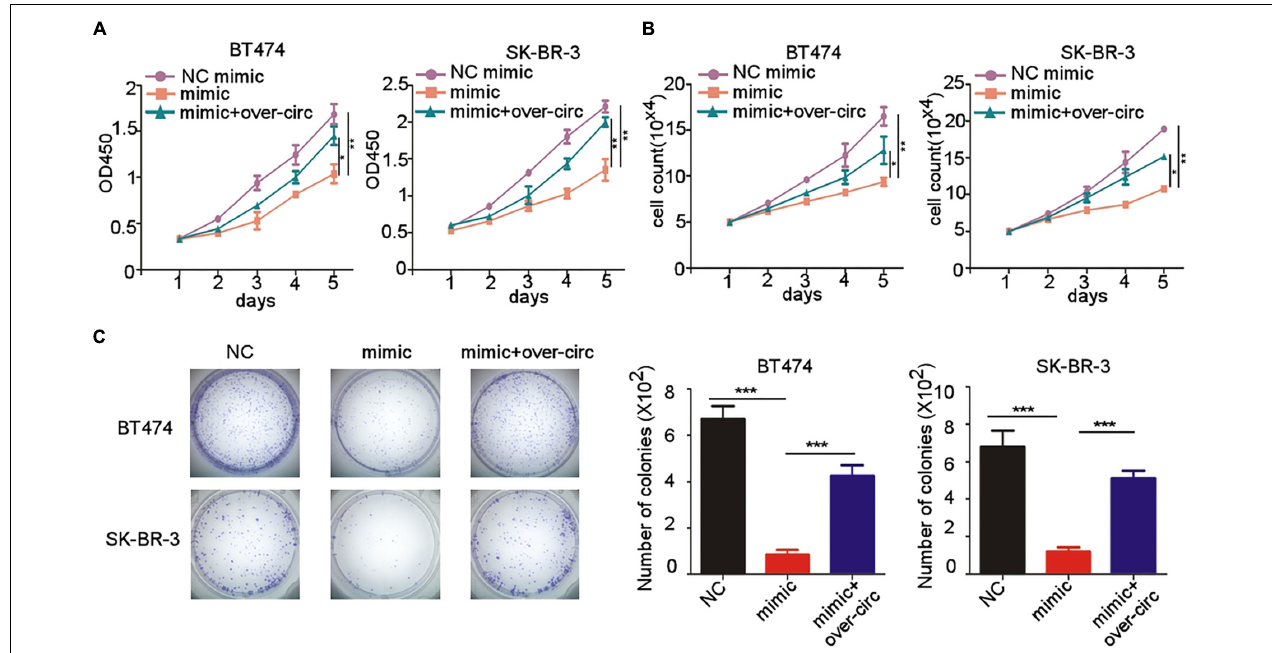
FIGURE 5 | miR-92b-3p inhibits proliferation of HER2 + BC cells by down-regulation of circCDYL. (A,B) The proliferation of SK-BR-3 and BT474 cells after transfection of miR-92b-3p mimic or co-transfection of miR-92b-3p mimic and circCDYL over-expressing plasmid, as detected by CCK-8 assay (A) and cell counting experiments (B) . (C) Plate colony formation to detect the proliferation of SK-BR-3 and BT474 cells after transfection of miR-92b-3p mimic or co-transfection of miR-92b-3p mimic and circCDYL over-expressing plasmid (left), and quantitative analysis of colonies of each group (right). * P < 0.05, ** P < 0.01, and *** P < 0.005. Error bars indicate S.E.M.